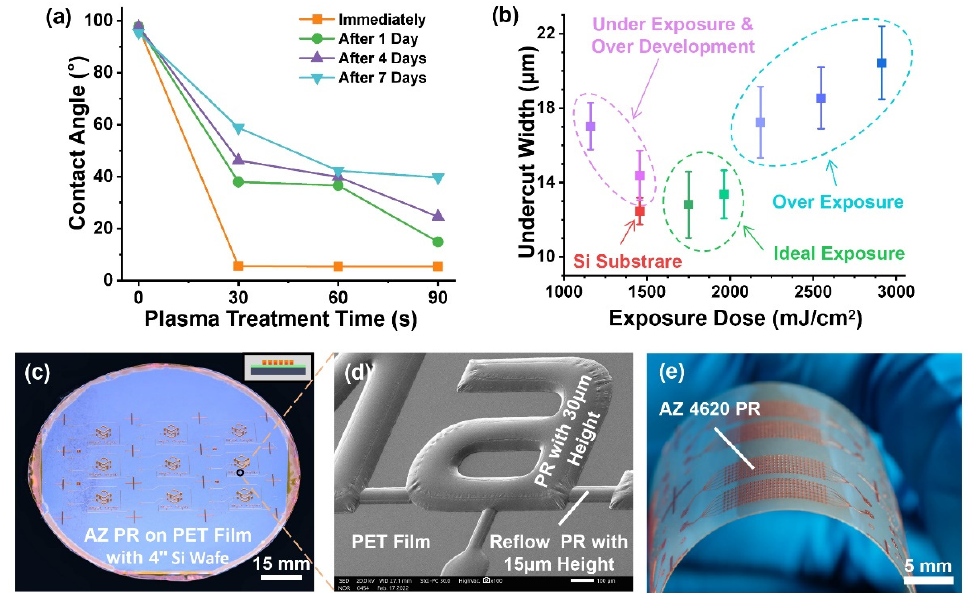
Figure 4. Fabrication results of the flexible mold: ( a ) influence on the contact angle of the PET surface with different oxygen plasma treatment time and standing time. ( b ) Effect of different exposure doses on single-side undercut width of the 20 μ m-height PR structure. Two-layered PR structures with 5 μ m-height reflow PR and 30 μ m-height PR on the PET film: ( c ) 4-inch wafer picture and ( d ) SEM picture. ( e ) Excellent adhesion and flexibility of AZ 4620 PR on the PET film.